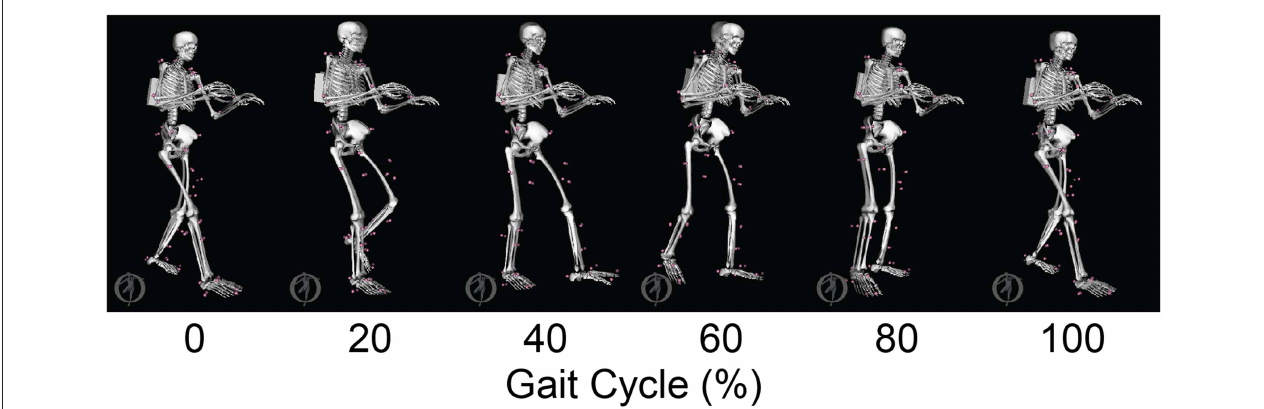
FIGURE 2 | Animation strip comparing the subject’s experimental gait motion (translucent skeleton) with his verification gait motion (opaque skeleton). The verification gait motion was predicted by a direct collocation optimal control problem that used the subject’s personalized neuromusculoskeletal model but did not track any experimental quantities in the cost function. This gait motion prediction was used to gain confidence in the personalized model and optimal control problem formulation.